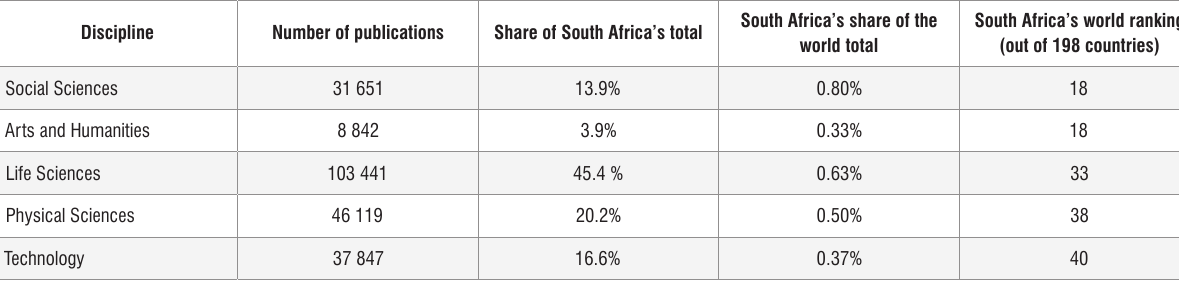
Source: Authors’ calculations on data from NACI